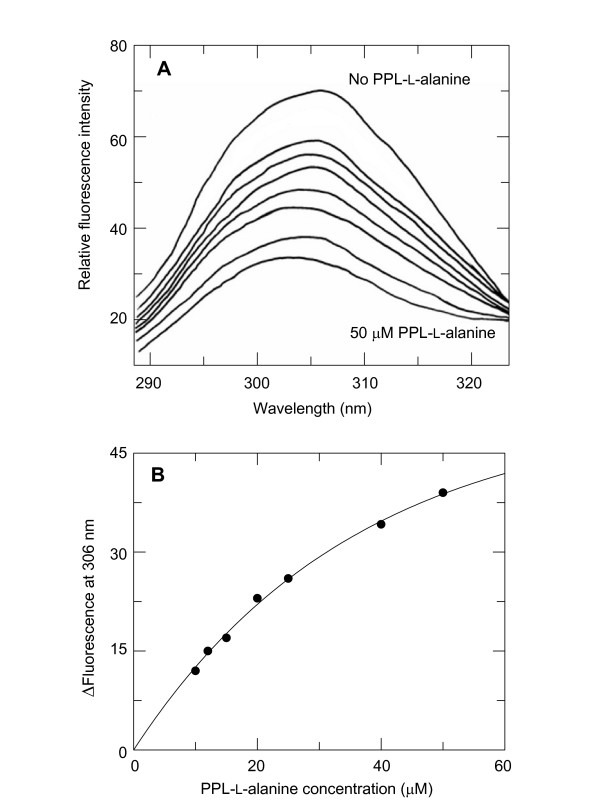
Fluorescence titration of RNase(K41R) with PPL-L-alanine. Fluorescence was measured with 5 μM RNase(K41R) in 50 mM 4-methylmorpholine pH 7.5 at 25°C. PPL-L-alanine concentrations were 10, 12, 15, 20, 25, 40 and 50 μM. A, Fluorescence spectra; B, nonlinear regression analysis gives a K'd value of 23 μM. Bovine RNase A contains six tyrosine residues and no tryptophan residue [45].